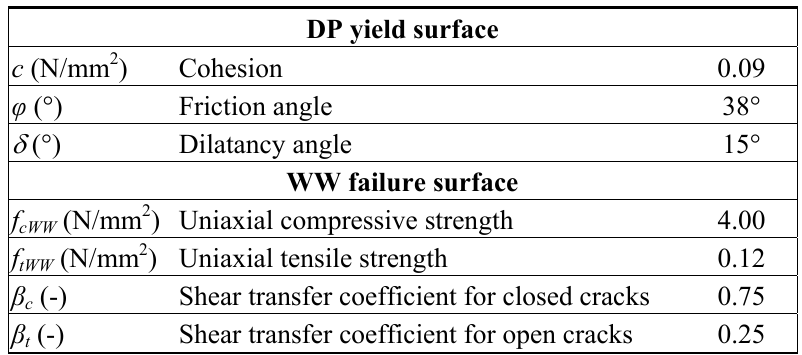
Table 2. Constitutive parameters of the masonries adopted for nonlinear FEM analyses (DP = plasticity criterion and WW = failure